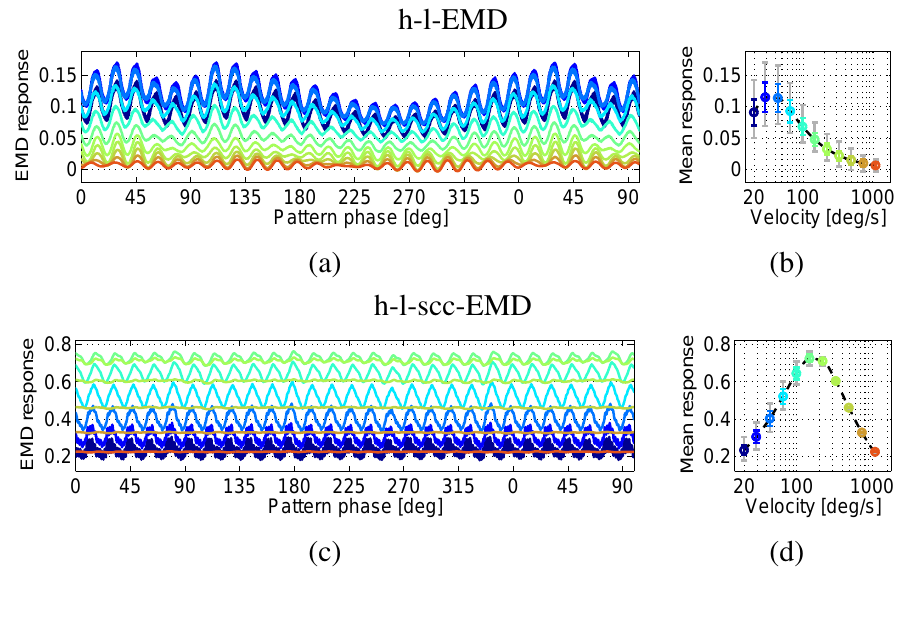
Figure 6. Responses of an h-l-EMD array ( a , b ) and an h-l-scc-EMD array ( c , d ) to a sine pattern with local noise and changes in local intensity. (a) and (c) show the responses versus pattern phase for eleven different velocities after the initial response transient has faded away. (b) and (d) represent the velocity dependence of the mean response amplitude (logarithmic velocity axis). The dashed line represents the approximated velocity curve. Markers indicate the calculated mean values. Additionally the standard deviation (coloured) and the minimum to maximum range of values (grey) are shown. (a, b) h-l-EMD array: The noise leads to a strong response modulation in comparison to the response to the perfect sine pattern. The different velocities cannot be distinguished as easily as is possible for the noise-free pattern. (c, d) h-l-scc-EMD array: The fluctuations in the response are reduced, especially the low-frequency ones, compared to those of the